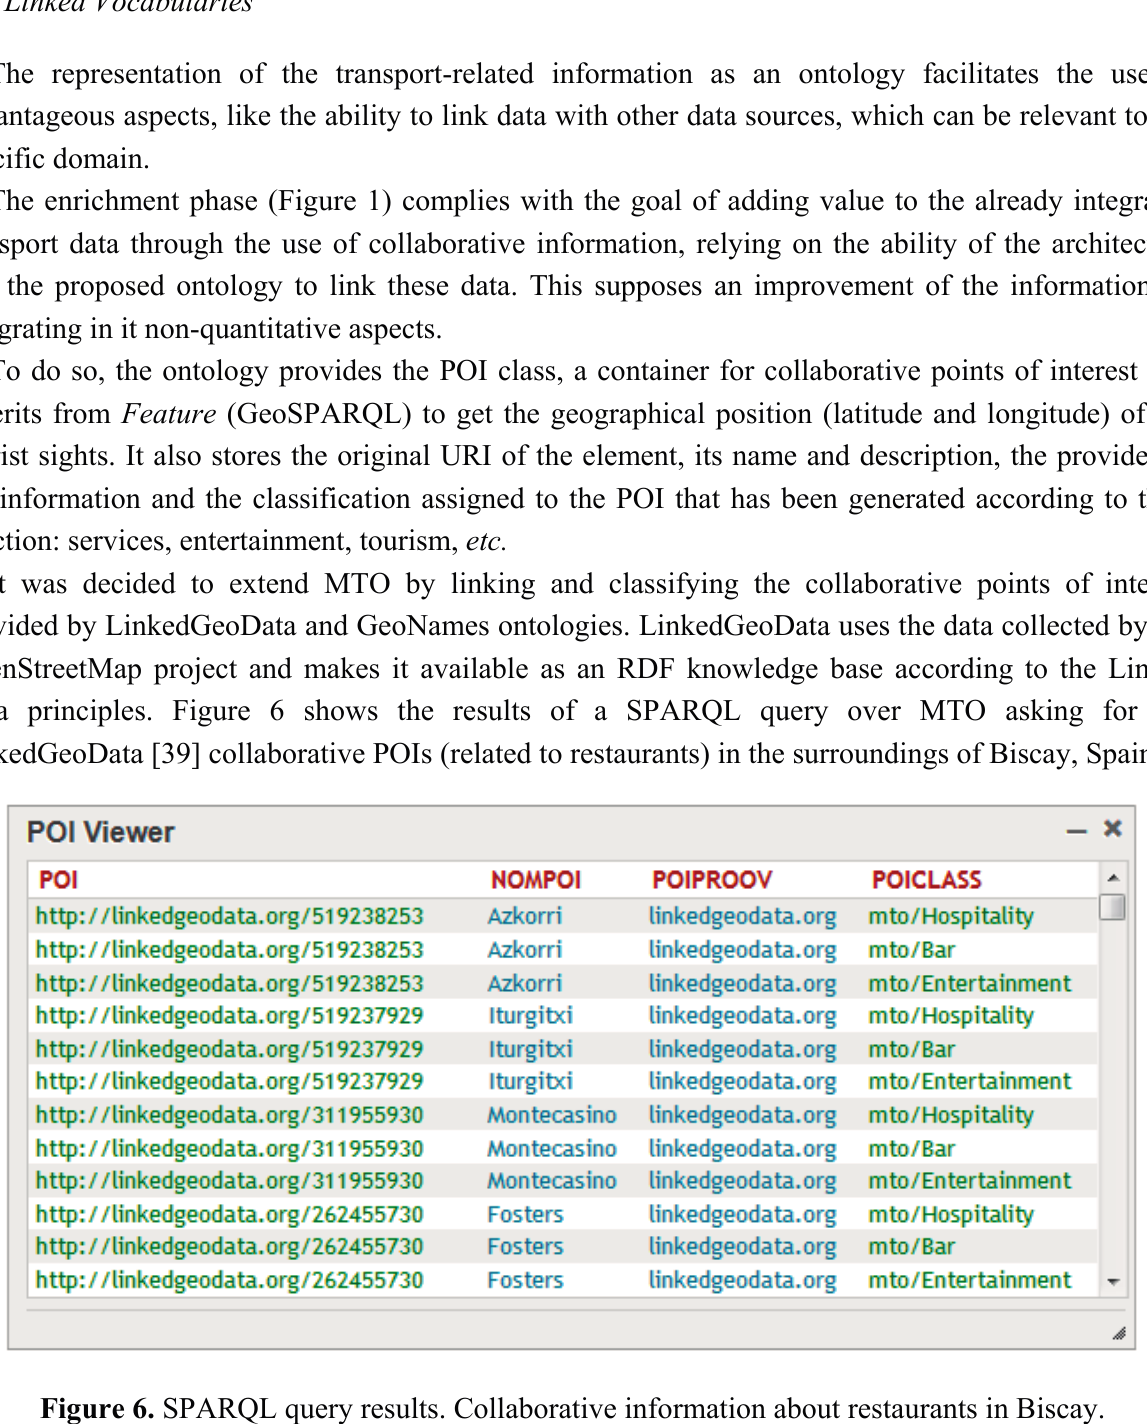
Figure 6. SPARQL query results. Collaborative information about restaurants in